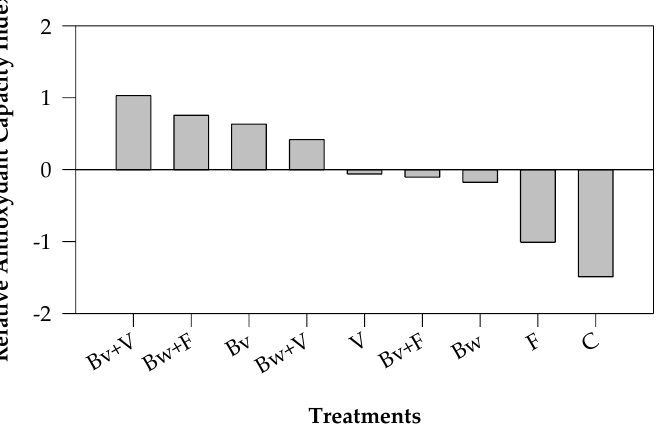
Figure 4. Relative Antioxidant Capacity Index (RACI). C, control; F, ammonium nitrate; V, ver- micompost; Bw, biochar from wood chips; Bv, biochar from vine prunings; Bw+F and Bv+F, biochars respectively mixed with ammonium nitrate; Bw+V and Bv+V, biochars respectively mixed with ver- micompost.